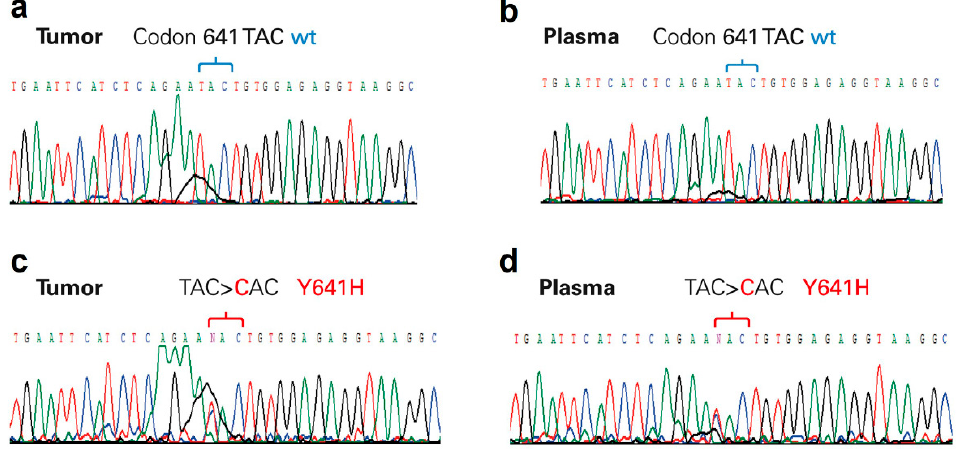
Figure 1. Chromatograms from Sanger sequencing. ( a ) Tumor and ( b ) plasma paired samples with wild-type EZH2-exon 16; ( c ) tumor and ( d ) plasma paired samples with EZH2 mutated at codon 641